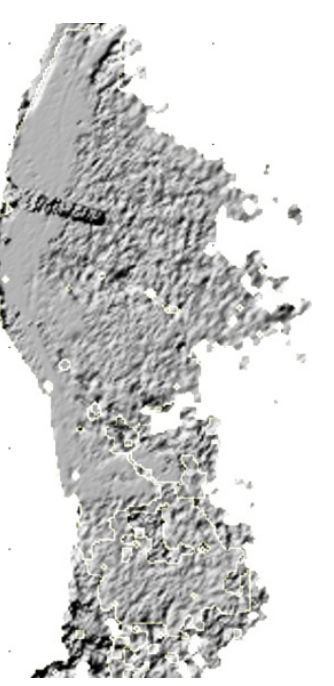
Figure 10 . Riegl survey